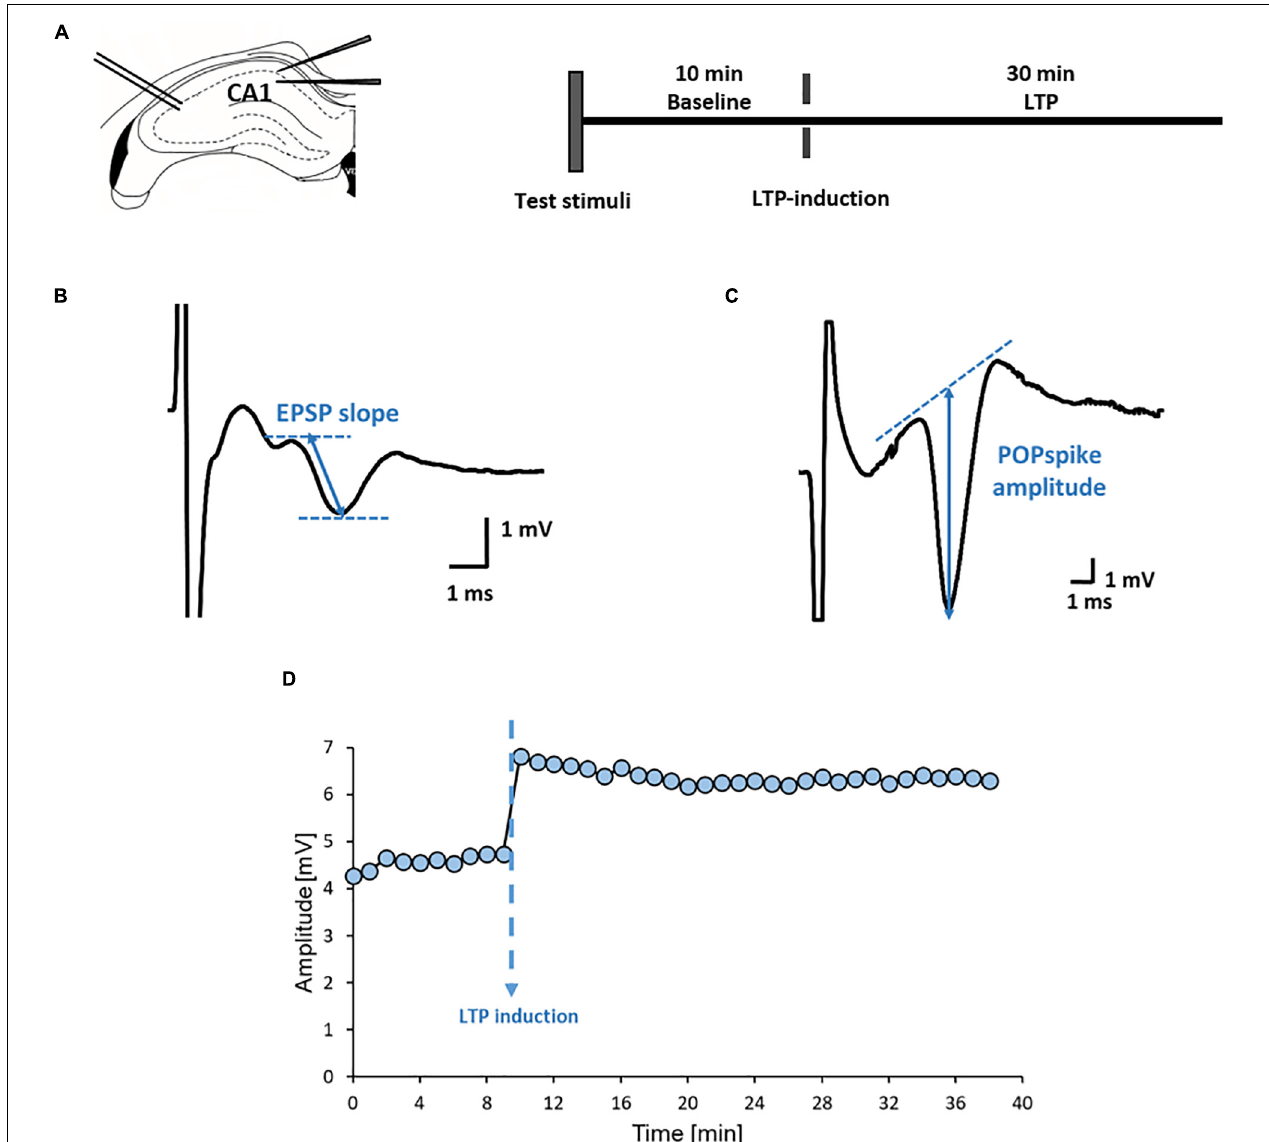
FIGURE 2 | Experimental protocols used in field potential measurements. (A) Positioning of the electrodes for registering field potentials in the hippocampus: stimulation at the Schaffer-collaterals and recording in the stratum radiatum and the stratum pyramidale and the timeline of experiments for hippocampus slices. (B) Representative evoked EPSP recorded from stratum radiatum and (C) POPspike recorded from stratum pyramidale. (D) Representative plot of POPS amplitude over time during LTP experiments. After a 10-minute-long baseline, LTP was induced via theta burst stimulation, then, recording was continued for 30